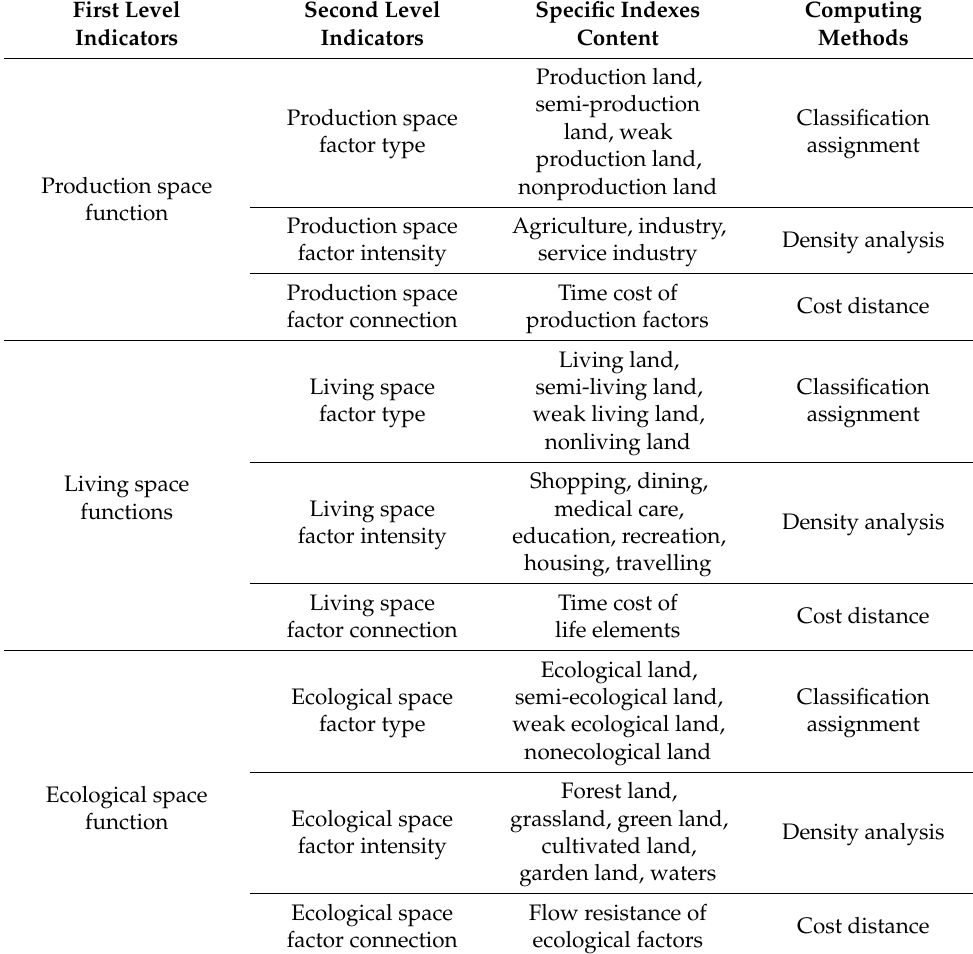
Table 1. Production–living–ecological space function evaluation methods and